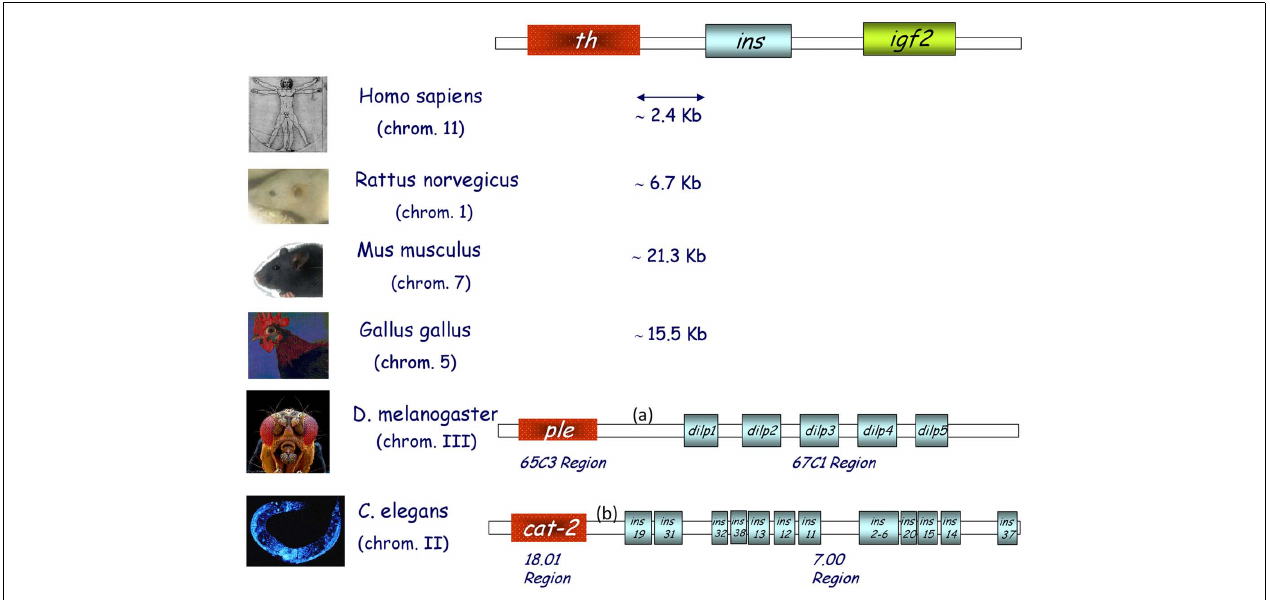
of both flies ( D. melanogaster ) and worms ( C. elegans ), some of which are located in the same region as monooxygenases. Chromosome numbers are indicated and intergenic DNA distances are depicted in kilobases (Kb). (a) is 3079Kb and (b) is